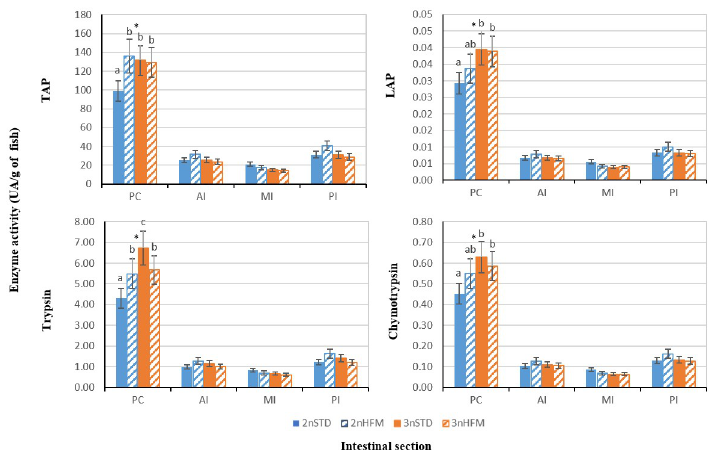
Fig 11. Total alkaline proteases (TAP), trypsin, leucine aminopeptidase (LAP) and chymotrypsin activity (expressed as UA/g of fish) of diploid (2n) and triploid (3n) Atlantic salmon, Salmo salar , fed fish meal (STD) and hydrolysed fish protein (HFM) diets measured at 2745 ddPSF sampling point (see Table 1: 38 weeks after start feeding). Four intestinal sections were considered: pyloric caeca (PC), anterior intestine (AI), medium intestine (MI) and posterior intestine (PI). Different letters denote significant differences (P < 0.05). Data are presented as means ± SE (n = 15). ( � ) Indicates significant differences between 2n and 3n in each section (P <